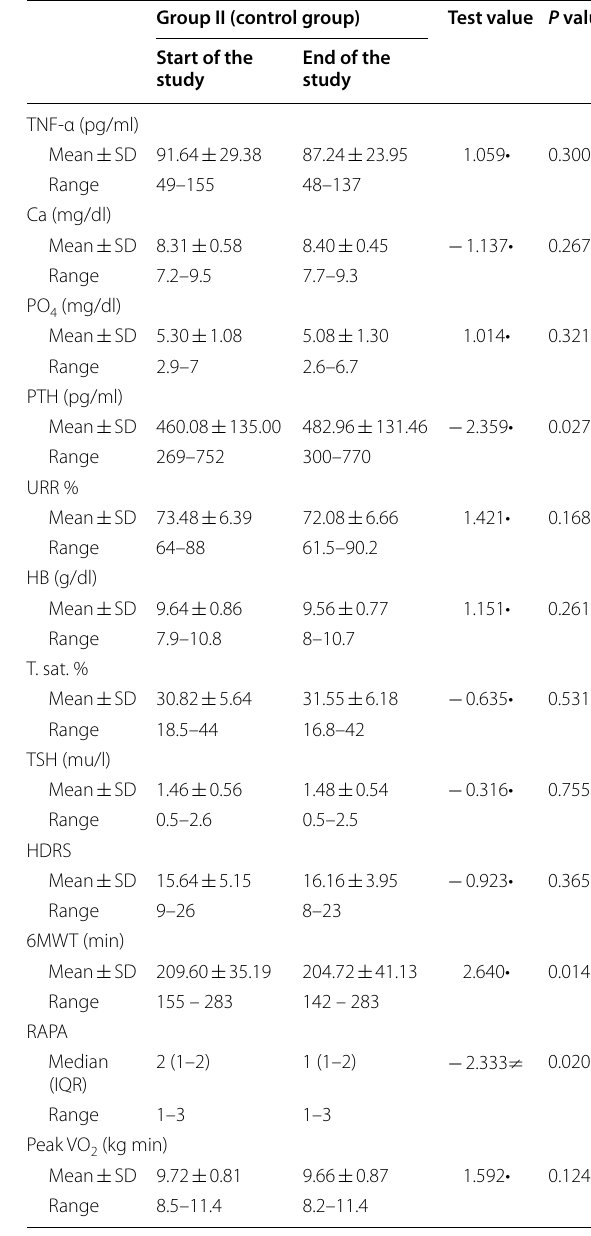
Table 1 Comparison of laboratory tests, physical activity tests and HDRS scores before and after exercise in group I